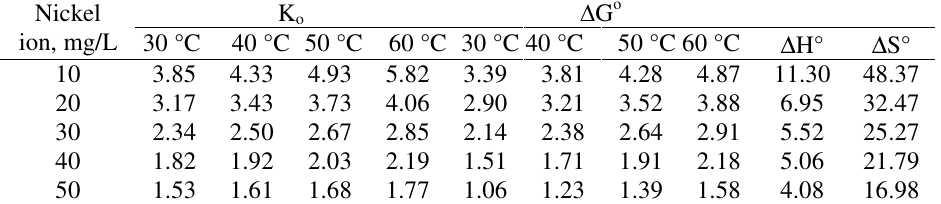
Table 6 . Equilibrium constant and thermodynamic parameters for the adsorption of metal ions onto acid activated